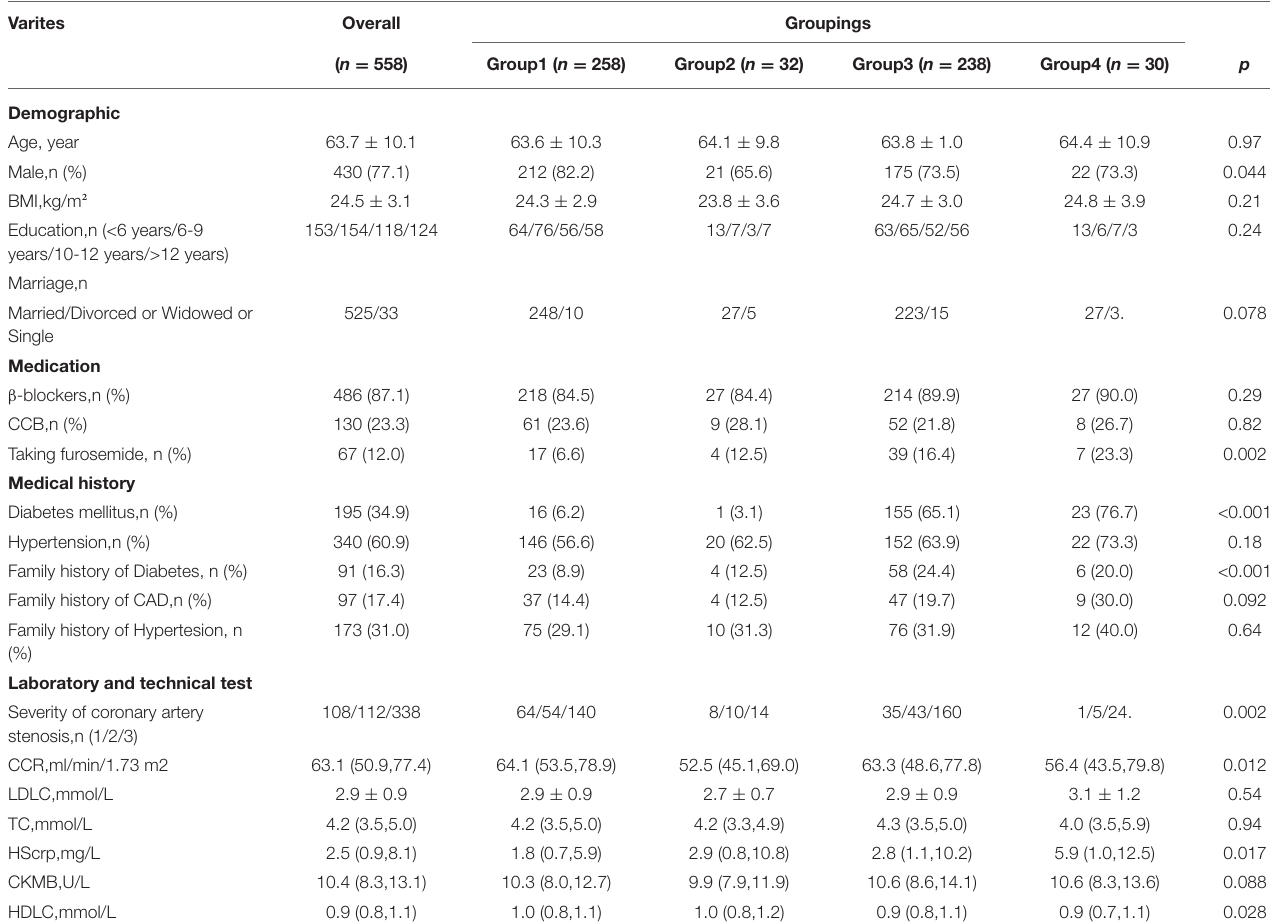
TABLE 1 | Baseline characteristic of all CAD patients grouped by clinical depression and HbA1c level. Varites